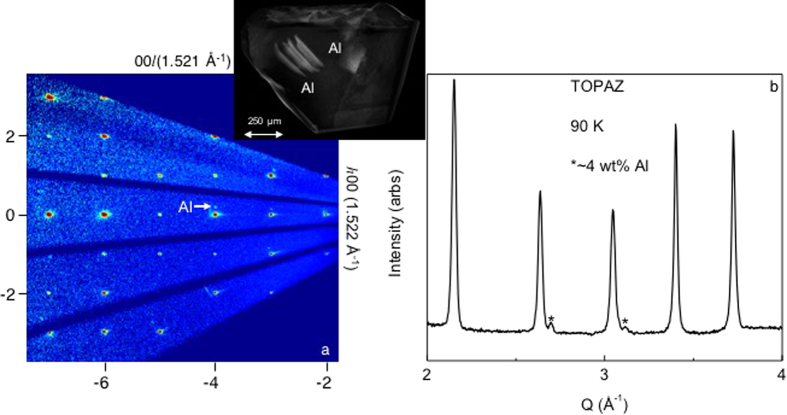
(a) A 00l versus h00 precession image of the 154Sm11B6 flux grown crystal collected at T = 90 K using the TOPAZ single crystal diffractometer located at the Spallation Neutron Source and a X-ray CT image showing the presence of inclusions within the 154Sm11B6 crystal. The companion reflections (see white arrow) correspond to epitaxial aluminum present in this flux grown crystal, determined using (b) a neutron diffraction histogram obtained from the radial integration of the single crystal neutron diffraction data. The asterisks denote the reflections from the epitaxial aluminum present in the flux grown crystal of SmB6.